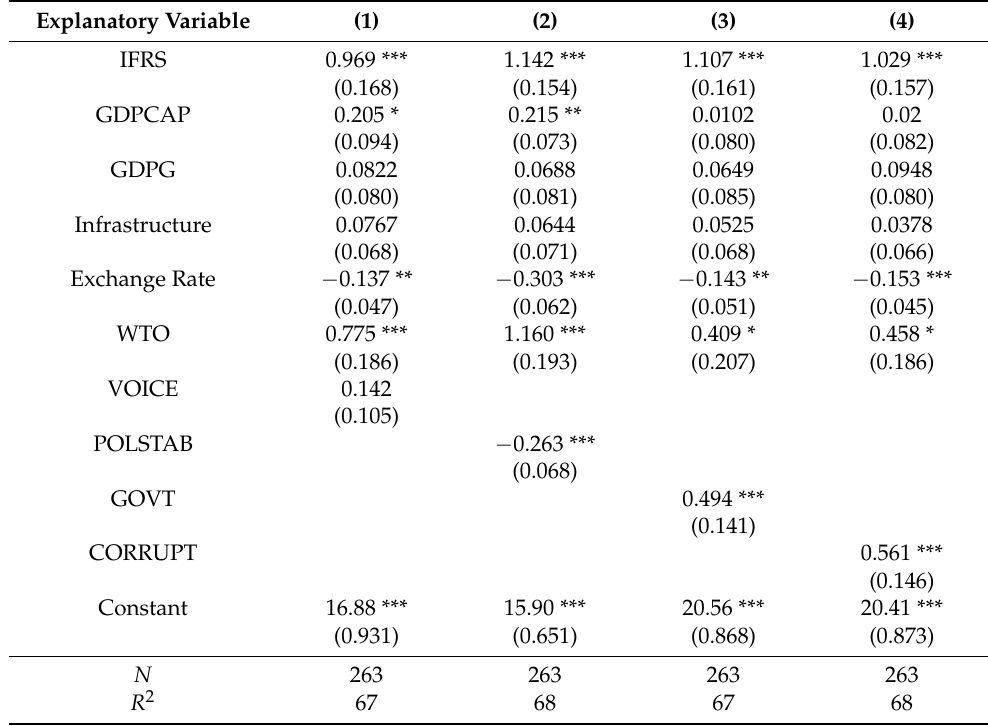
Table 5. PPML estimation results with individual time effects for North Africa countries